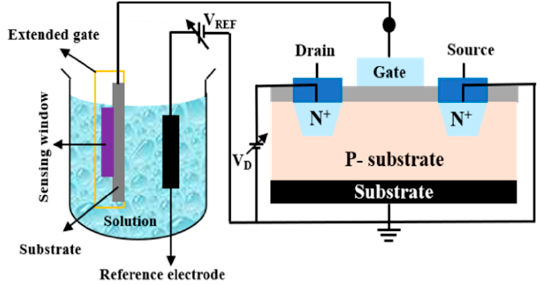
Figure 2. The basic cross-section of EGFET.